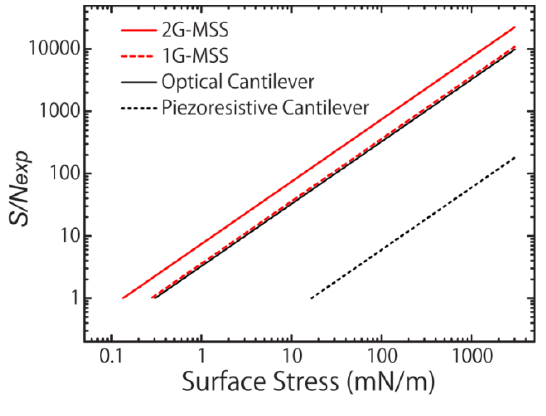
Figure 7. Experimental signal-to-noise ratio ( S/N (red dashed line), the optical cantilever (black solid line), and the piezoresistive cantilever (black dashed line) as a function of the induced surface stress. The experimental noises ( N ); 1.0 μ V and 1 nm for piezoresistive and optical read-outs, exp